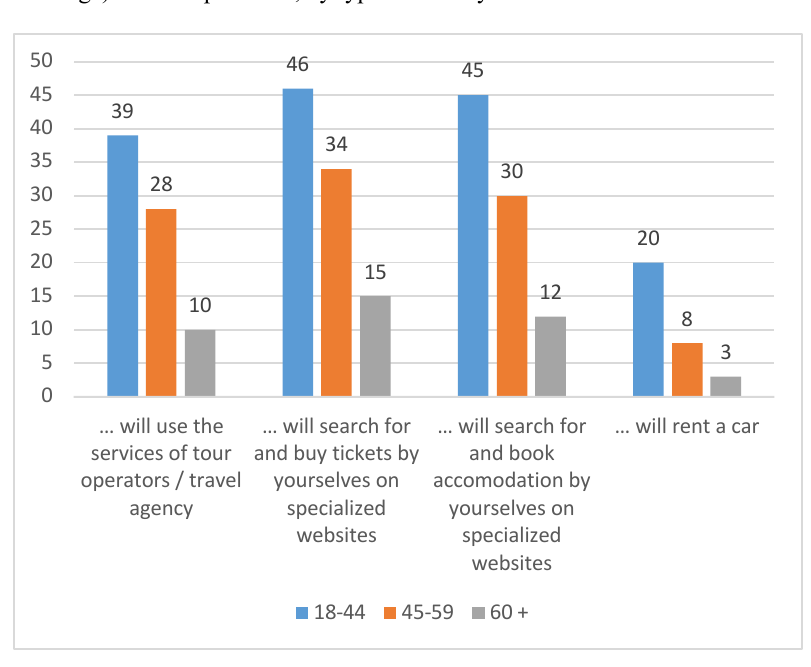
Fig. 3. The results of respondents’ answers by